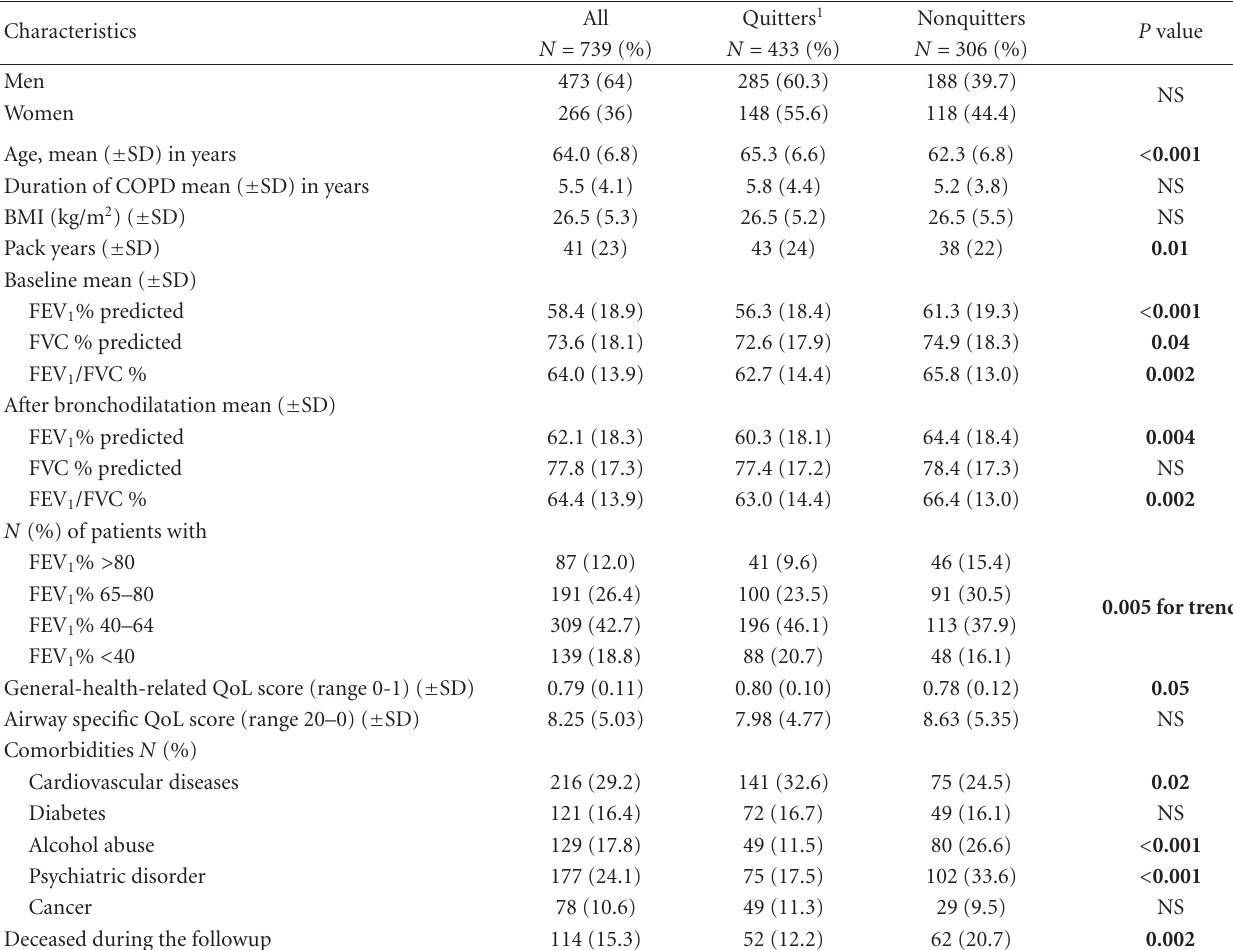
Table 1: Demographics and clinical characteristics of quitters and